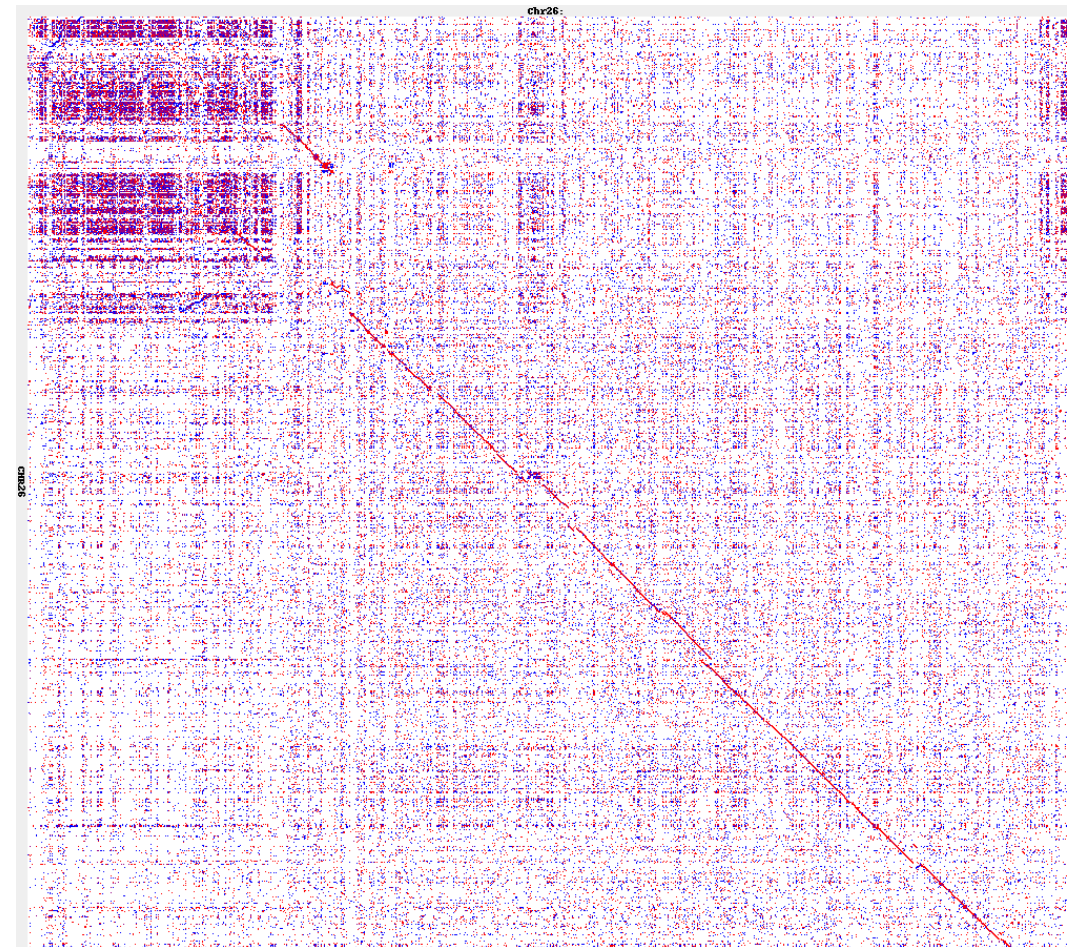
Figure A1. LAST dotplot alignment of chromosome 26 pseudomolecules of A. chinensis var. chinensis ’Red5 ′ ( y -axis) with A. eriantha ‘White’ ( x -axis).